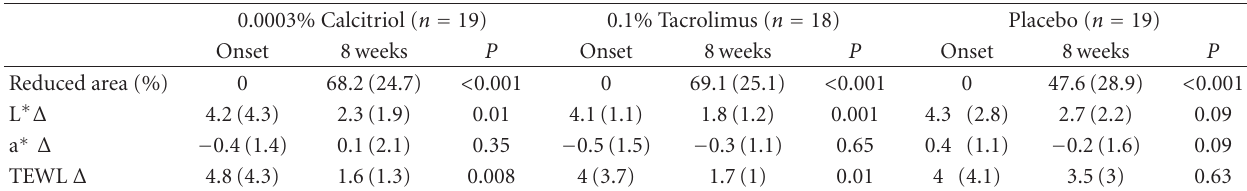
Figure 4: PA lesion treated with 0.1% tacrolimus ointment in a 7-year-old boy: onset and 8 weeks later with excellent improvement. Table 2: Changes in repigmented area (%), colorimetric values (L ∗ , a ∗ ), and TEWL (g/m 2 /h) on target lesions of PA. Data are shown initially, and at the end of study for calcitriol, tacrolimus and